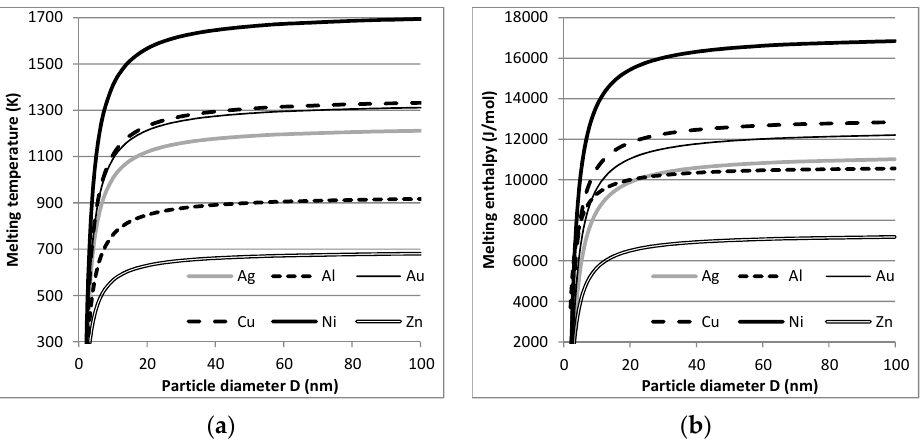
Figure5. Size-dependentmeltingpoints( a )andmeltingenthalpy( b Figure 5. Size-dependent melting points ( a ) and melting enthalpy ( b ) for six metallic nanoparticles (NPs).